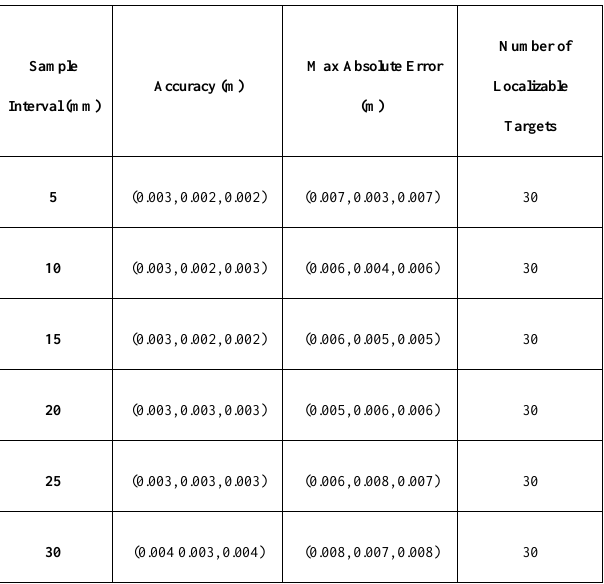
Table 2. The target localization accuracy using the presented Sample